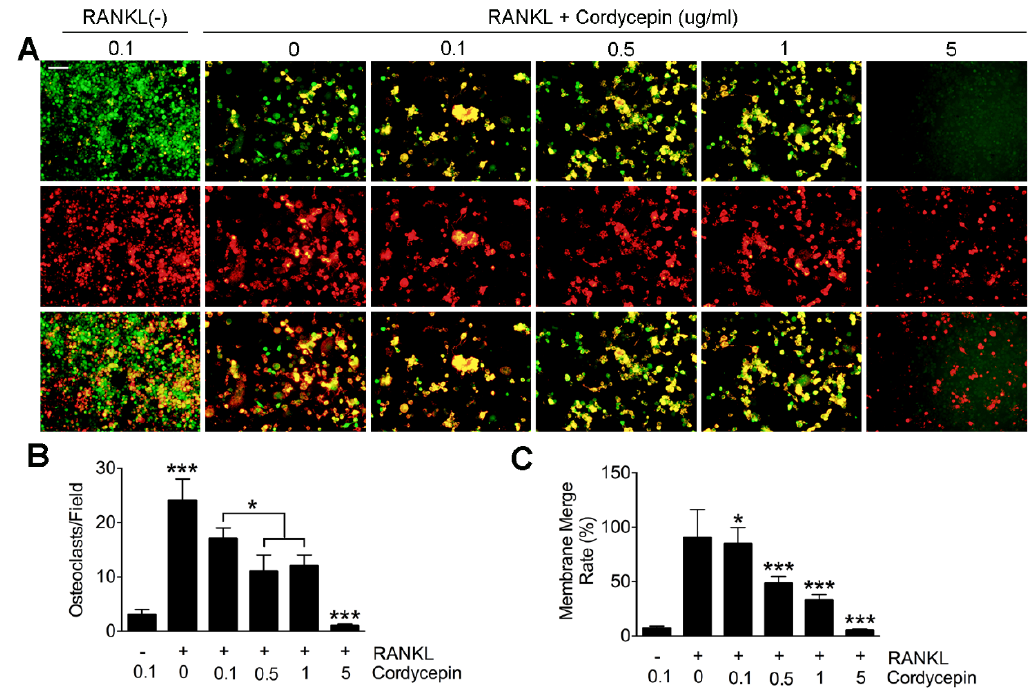
Figure 3. Cordycepin inhibits RANKL-induced osteoclast fusion in a dose-dependent way. Cells were labeled with either membrane dye DiI (red color) or cell content marker Cell tracker (green color) and then mixed together for fusing process. ( A ) Representative images of fusion assay. Primary BMMs treated without RANKL, M-CSF and cordycepin were set as blank control group. Five different groups were set according to different concentrations of cordycepin treatment (0 µ g/mL, 0.1 µ g/mL, 0.5 μ g/mL, 1 μ g/mL, and 5 μ g/mL). ( B ) Quantification of osteoclasts (nuclei ≥ 3) in each field. ( C ) Membrane merge rate of osteoclasts in each field. Scale bar represents 40 µ m. Data in the figures represent average ˘ SD. * p < 0.05, *** p < 0.001 based on one way